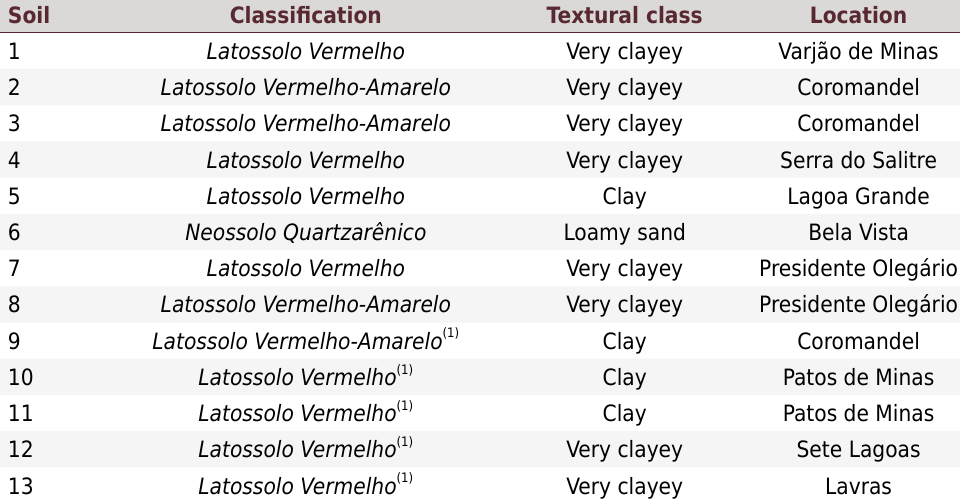
Table 1. Classification, textural class, and location of the soils sampled